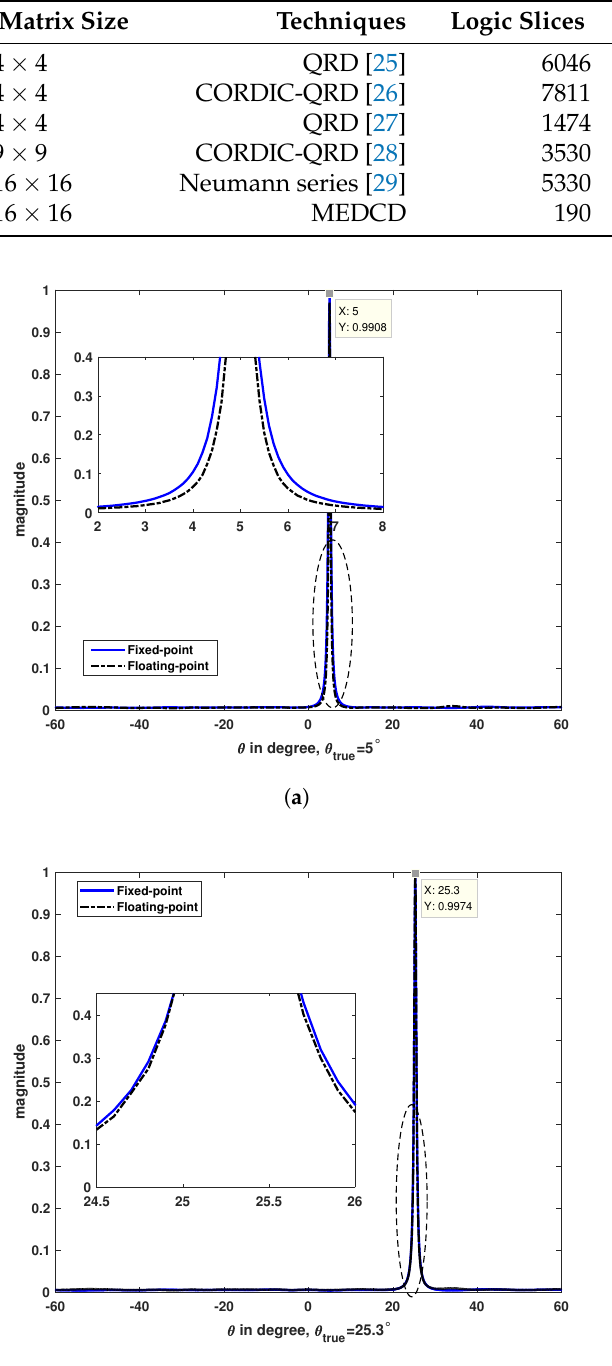
Figure 5. DoA estimation using MEDCD-RLS-DL. ( a ) DoA estimation for θ true = 5 ◦ . ( b ) DoA estimation for θ true = 25.3 ◦